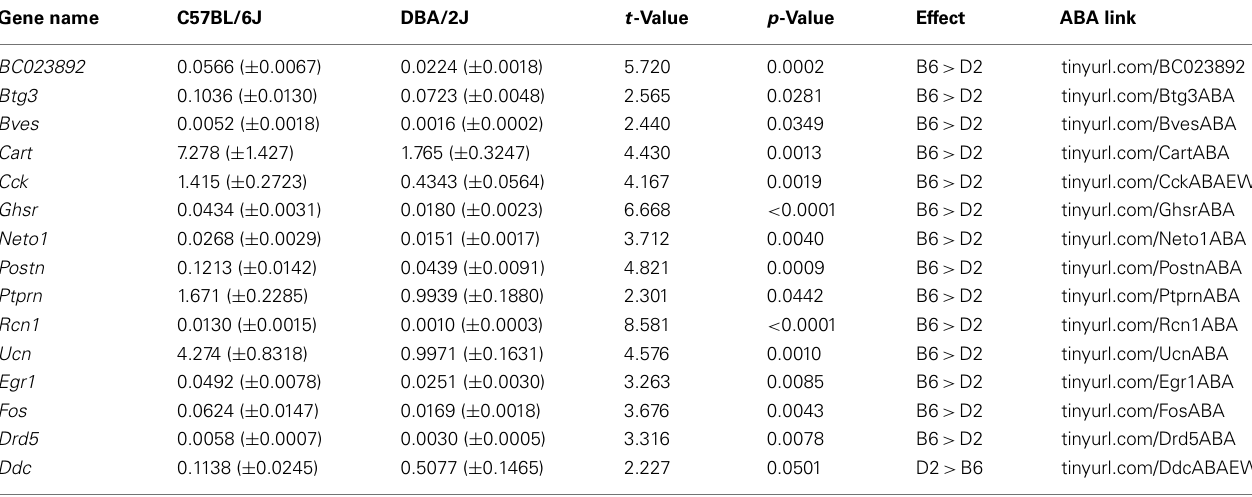
Table 3 | Genes of interest showing expression differences between strains by qPCR array of EWcp